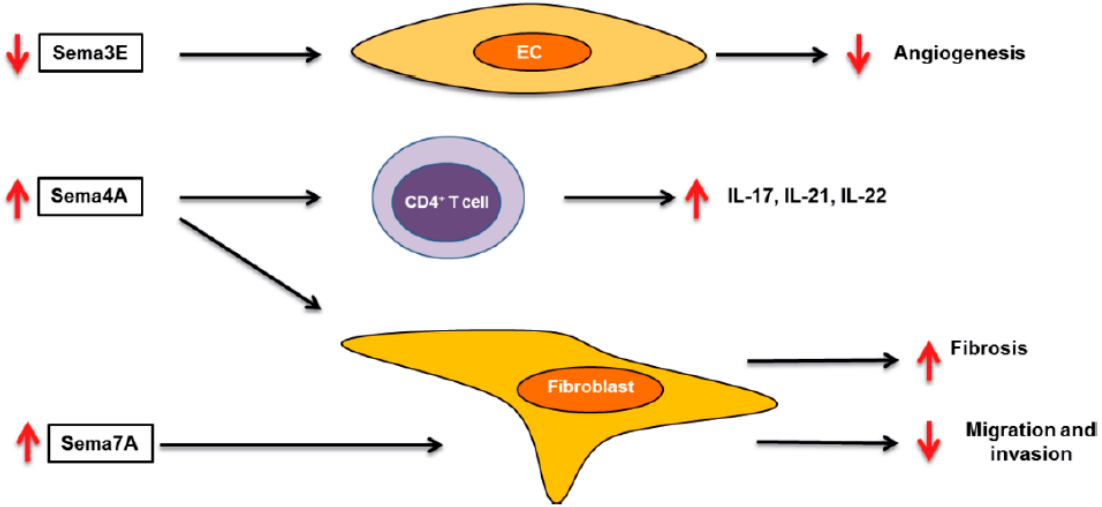
Figure 2. Role of semaphorins in systemic sclerosis. Schematic overview of the role semaphorins in the pathology of systemic sclerosis SSc. Up red arrows and down red arrows indicate induction or reduction, respectively. EC (endothelial cell).